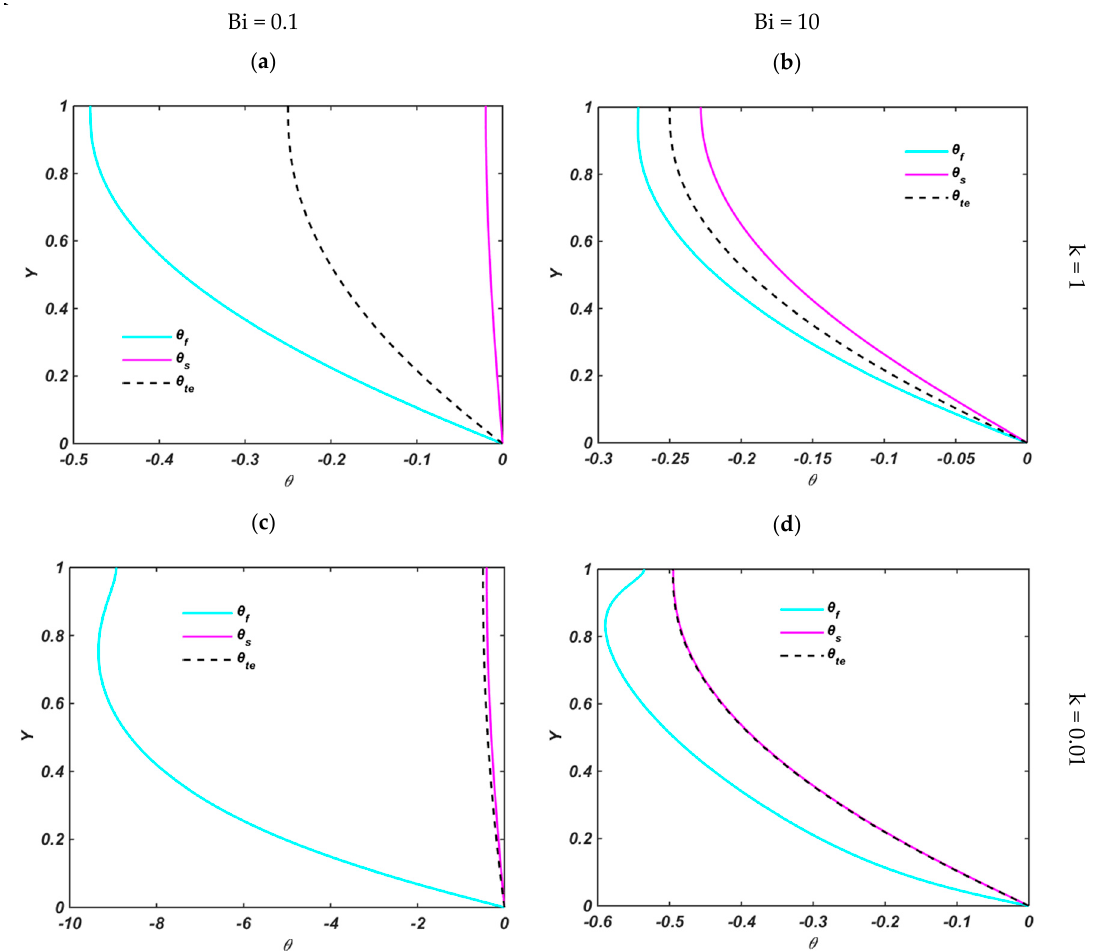
Figure 4. Comparison of local thermal equilibrium (LTE) and local thermal non-equilibrium (LTNE) results: ( a ) Bi = 0.1 and k = 1. ( b ) Bi = 10 and k = 1. ( c ) Bi = 0.1 and k = 0.01. ( d ) Bi = 10 and k = 0.01